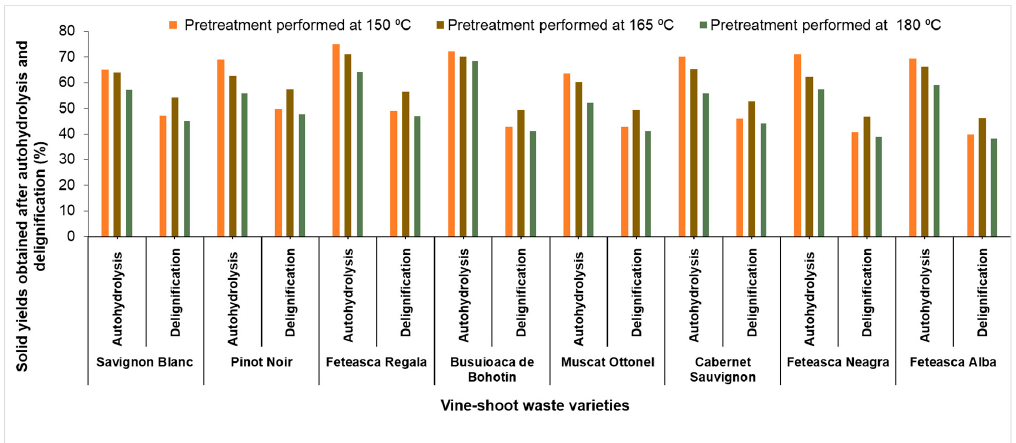
Figure 4. Solid yields obtained after delignification and pretreatment of shoot wastes of the studied vine-shoot varieties.